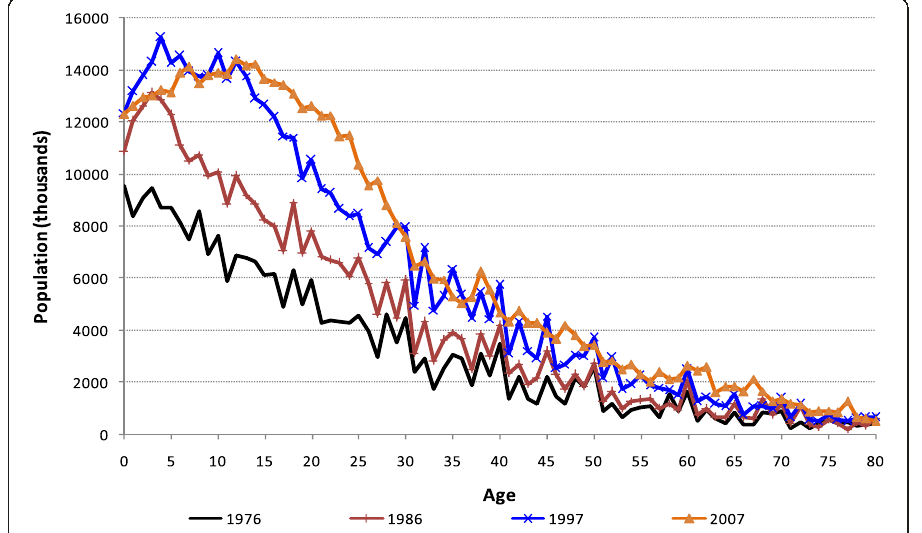
Fig. 1 Age distribution of females aged 0 – 80, Swaziland, 1976 – 2007 PHC. Source: published raw data from Swaziland Population and Housing Censuses